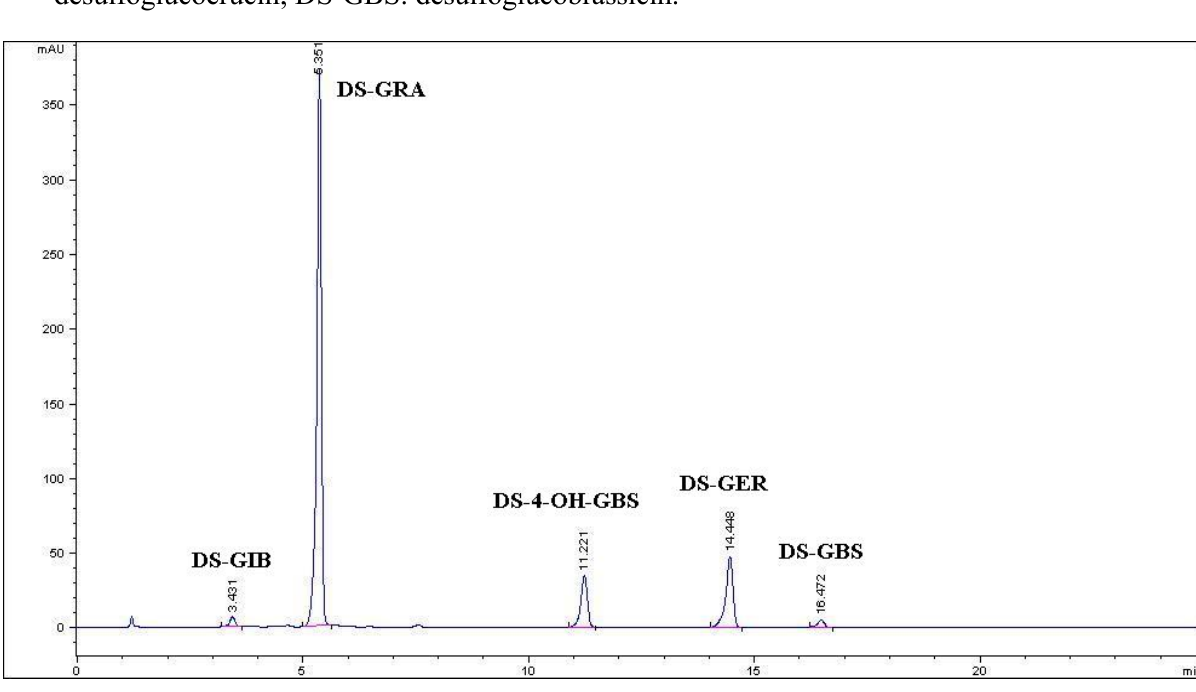
Figure 1. HPLC chromatogram of desulfo-glucosinolates (DS-GLs) isolated from an ethanolic extract of Tuscan black kale defatted seed meal. DS-GIB: desulfoglucoiberin; DS-GRA: desulfoglucoraphanin; DS-4-OH-GBS: desulfo-4-hydroxyglucobrassicin; DS-GER: desulfoglucoerucin; DS-GBS: